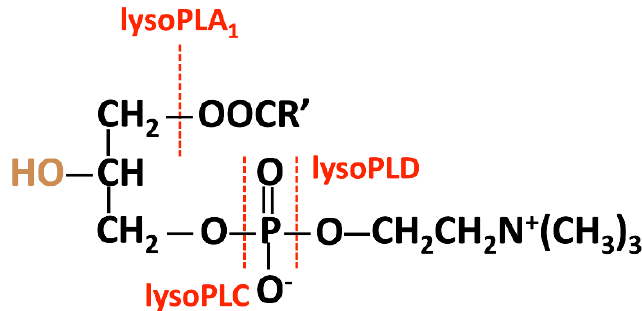
Figure 2. The hydrolysis of LPC is catalyzed by lysophospholipases A1, C, or D, according to the cleavage site.